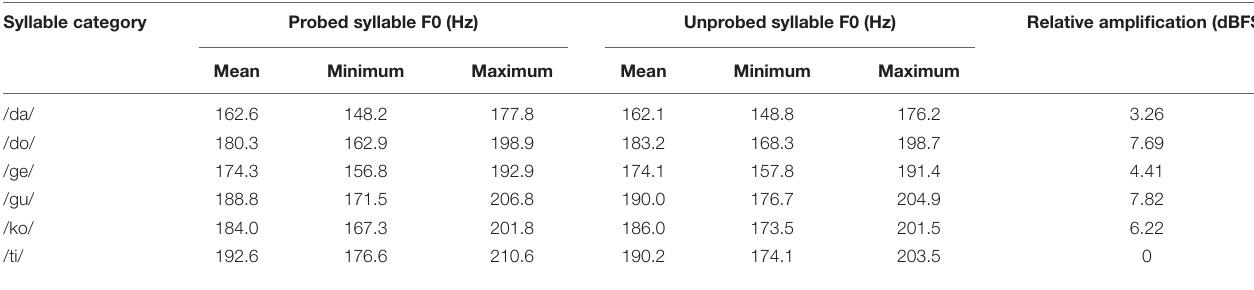
TABLE 1 | F0 and relative amplification values of the syllable stimuli as resulting from the subjective loudness rating procedure. Syllable category Probed syllable F0